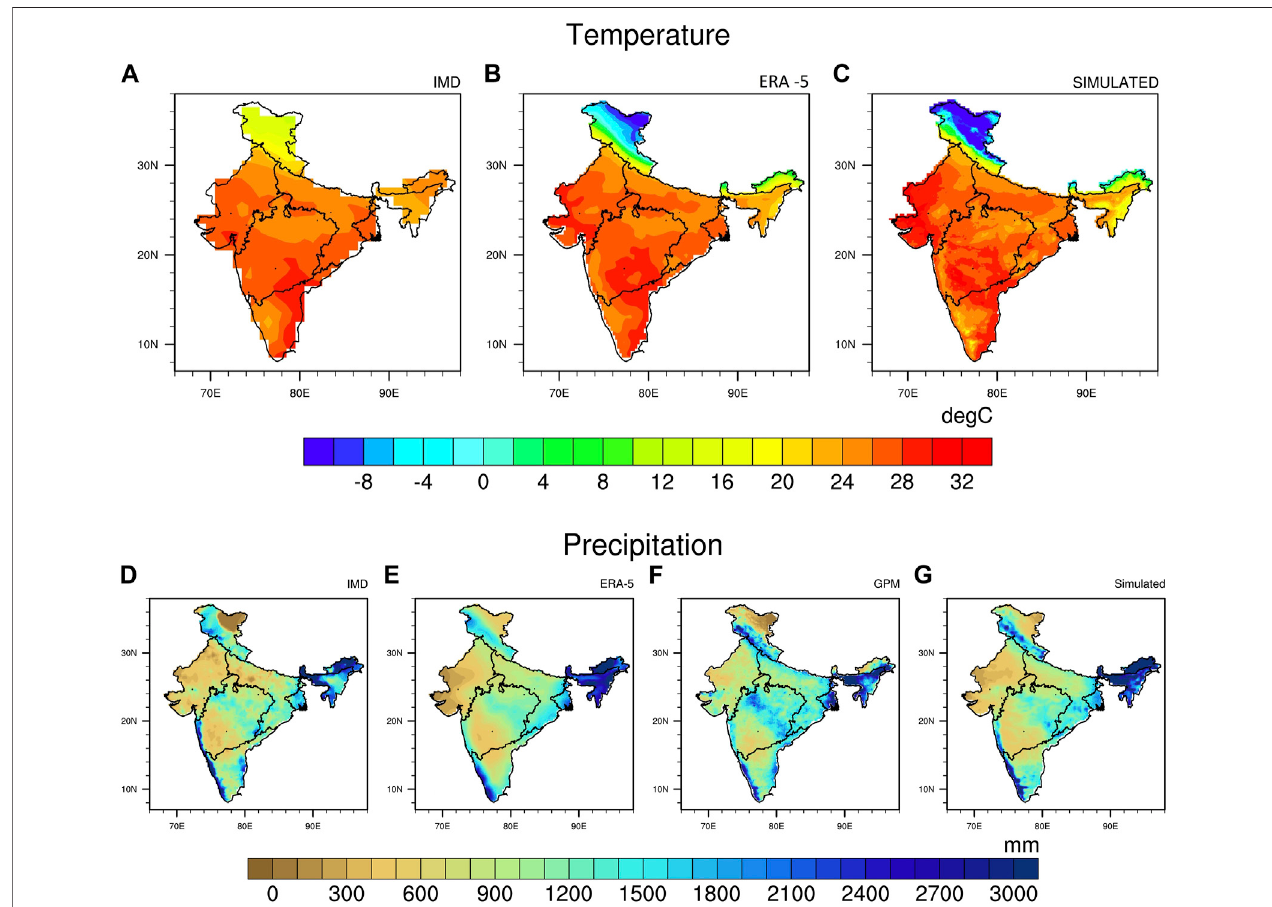
FIGURE 4 | Comparison of temperature (A) observed from IMD, (B) reanalysis from ERA -5, and (C) simulated temperature datasets based on LULC-2015, and precipitation (D) from IMD, (E) ERA-5, (F) GPM, and (E) simulated precipitation at varying horizontal resolution during the year 2015.